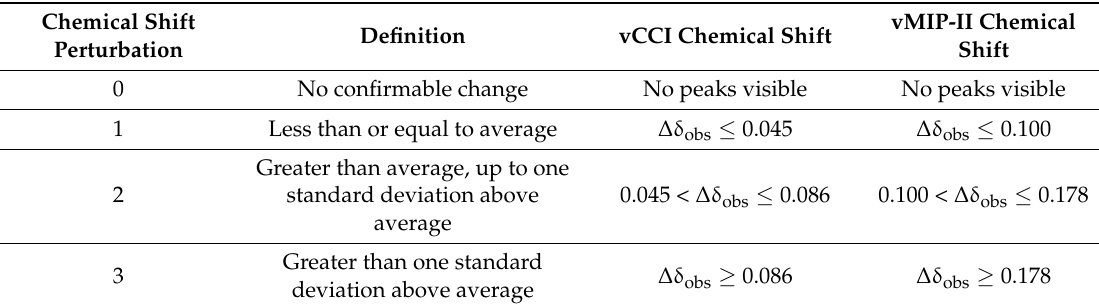
Table 1. Definitions of the chemical shift perturbation categories in Figure 3.